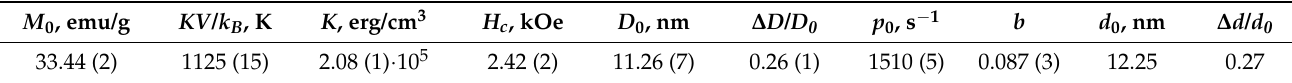
Table 2. Results of the analysis of the magnetization